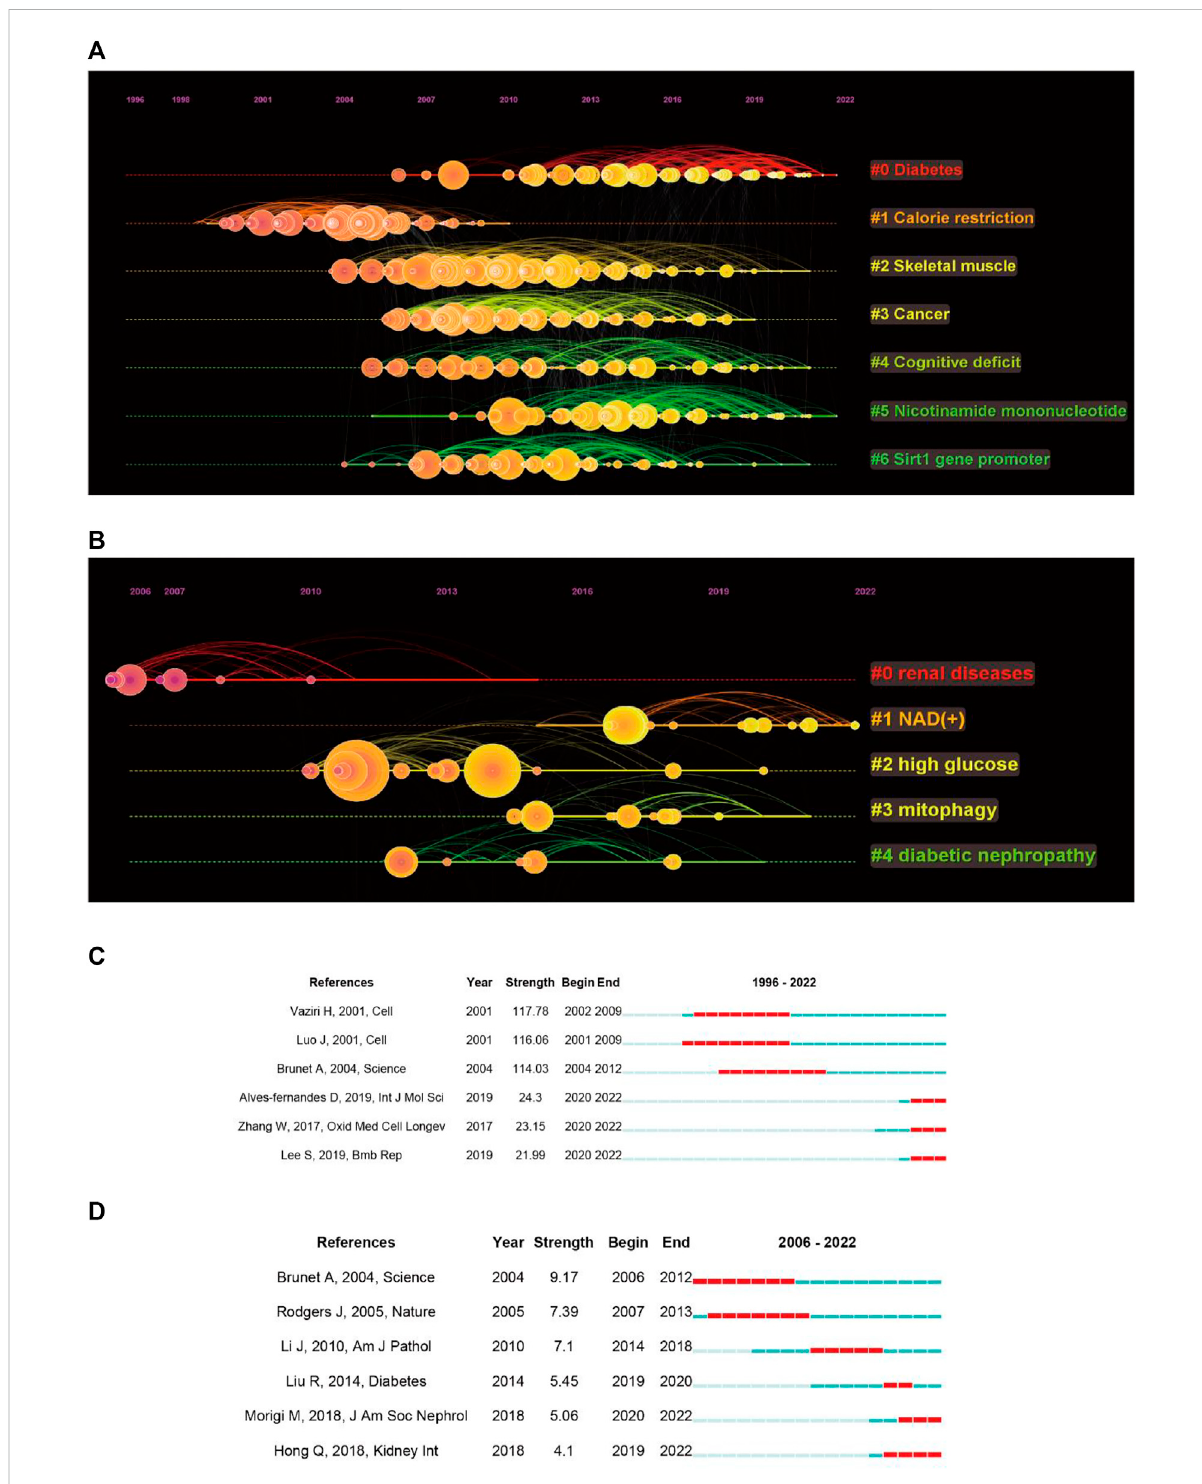
FIGURE 5 Co-cited references analysis. (A) Timeline plot of clustering concerning sirt1. (B) Timeline plot of clustering concerning sirt1 in kidney disease. (C) Burst analysis concerning sirt1. (D) Burst analysis concerning sirt1 in kidney